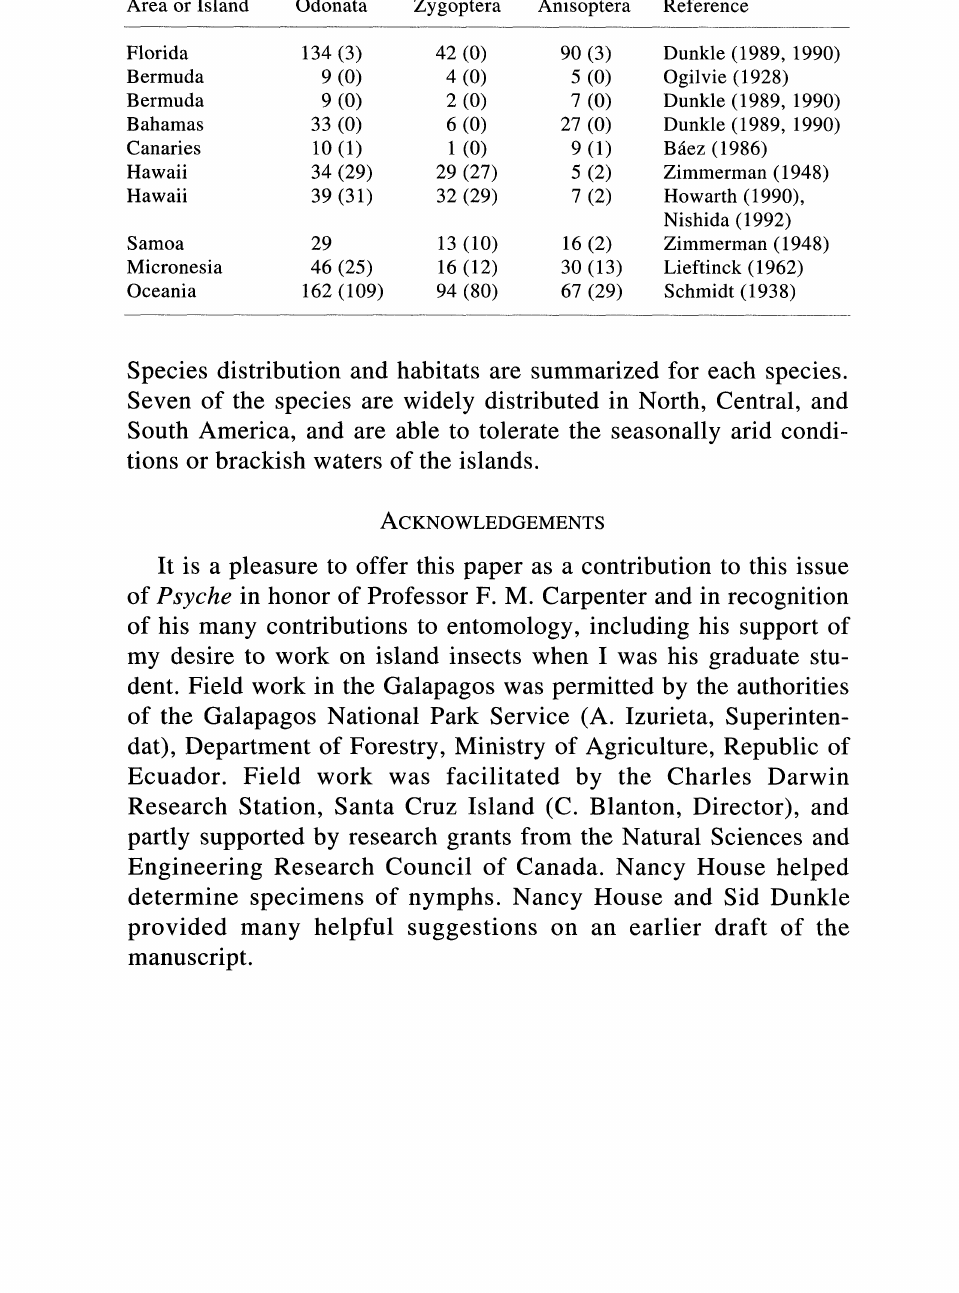
Table 1. Data on Odonata fauna of some island regions compared with peninsular Florida, giving number of species and subspecies (endemics in parentheses), and references. Other data are in Schmidt